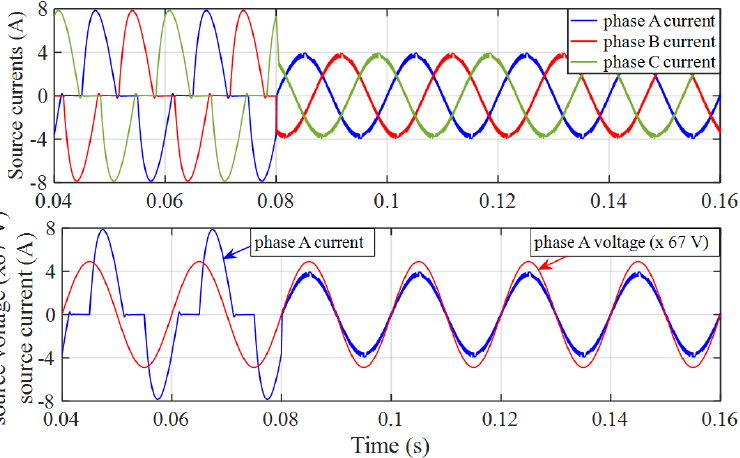
Figure 8. Source currents in UpfC practical simulation, connecting the APF at t = 0.08 s. Up: source currents with ITHD changing from 43% to 3.7%. Down: one phase source current and voltage, showing the PF compensation.